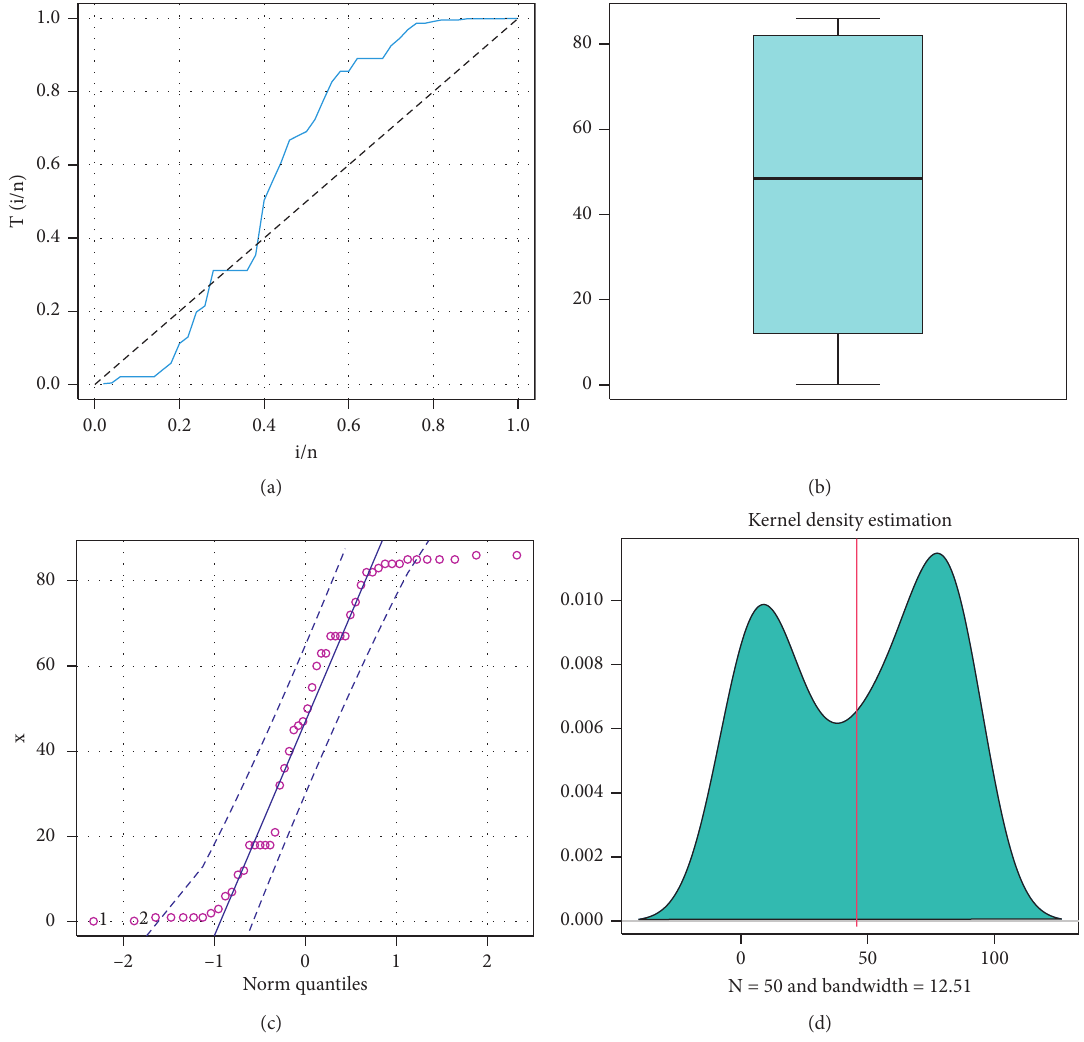
Figure 6: The TTT plot (a), box plot (b), QQ plot (c), and KDE plot (d) for the lifetimes data. Table 3: The MLEs for bladder cancer data.